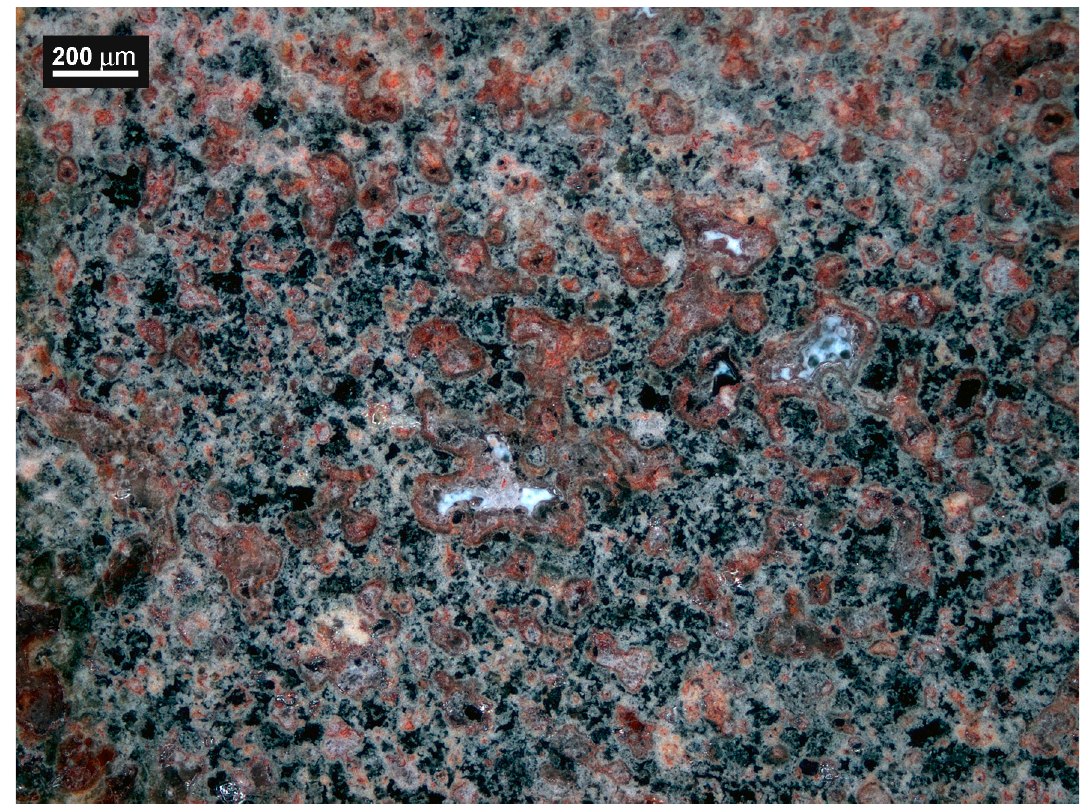
Fig 23. Appearance of the lump Bleje ş ti 1–2 core showing the colour diversity of its phases. The anglesite appears black, reddish, white and transparent crystalline. Palmierite is dispersed in clear crystalline form. OM image, Dark Field (S. Rovira).